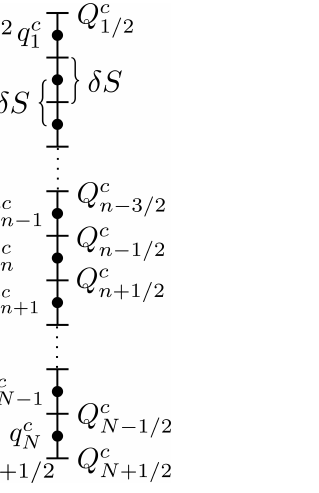
Figure 5. Sketch of how Q c and q c are located in a discrete salin- ity space. The salinity interval [ S 1 / 2 , S N + 1 / 2 ] is divided into N equidistant salinity classes of length δS . The entries of Q c ( Q c n ) are located on the lines, and the entries of q c ( q c n ) are located on the